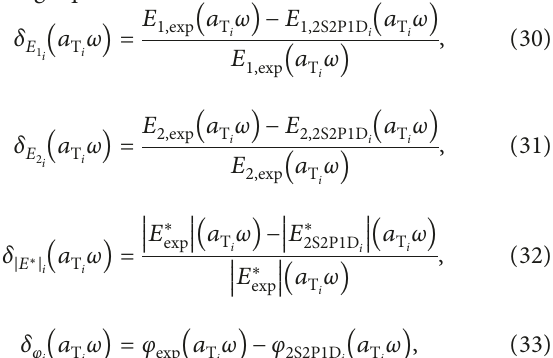
Table 3: WLF and 2S2P1D constants obtained for the bituminous mixture by all the users of the calibration panel ( T C ( − 1